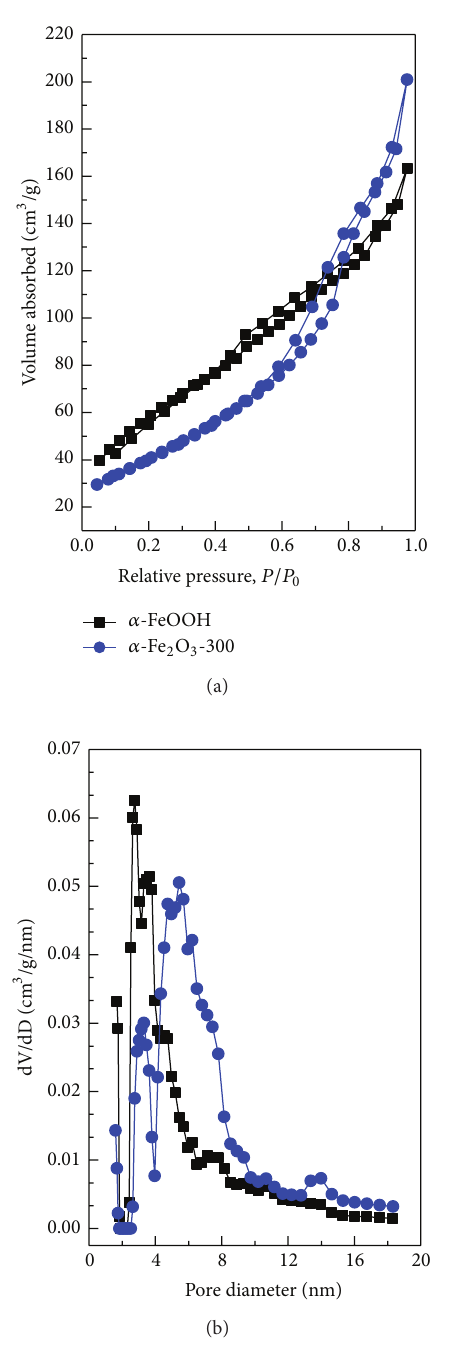
Figure 4: (a) N 2 adsorption-desorption isotherms and (b) the cor- responding pore size distribution curves of 𝛼 -FeOOH and 𝛼 -Fe 2 O 3 - 300.